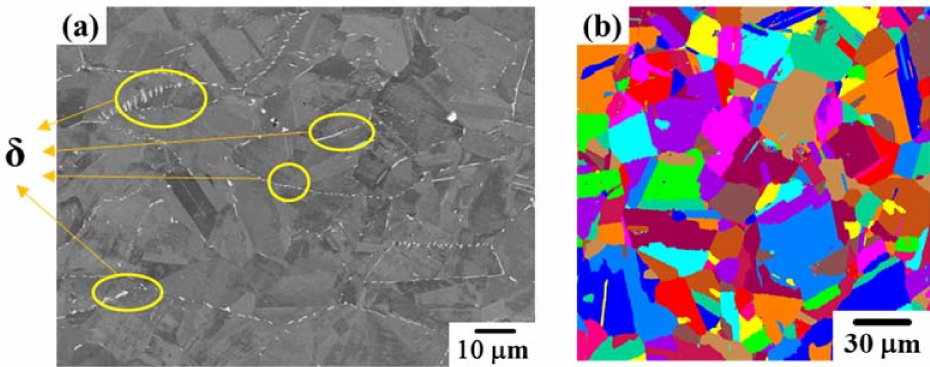
Figure 1. Microstructure of solid-solution-treated superalloy 718 with an average grain size of approximately 21 µ m: ( a ) FE–SEM image and ( b ) unique grain map ( θ < 15 ◦ ).